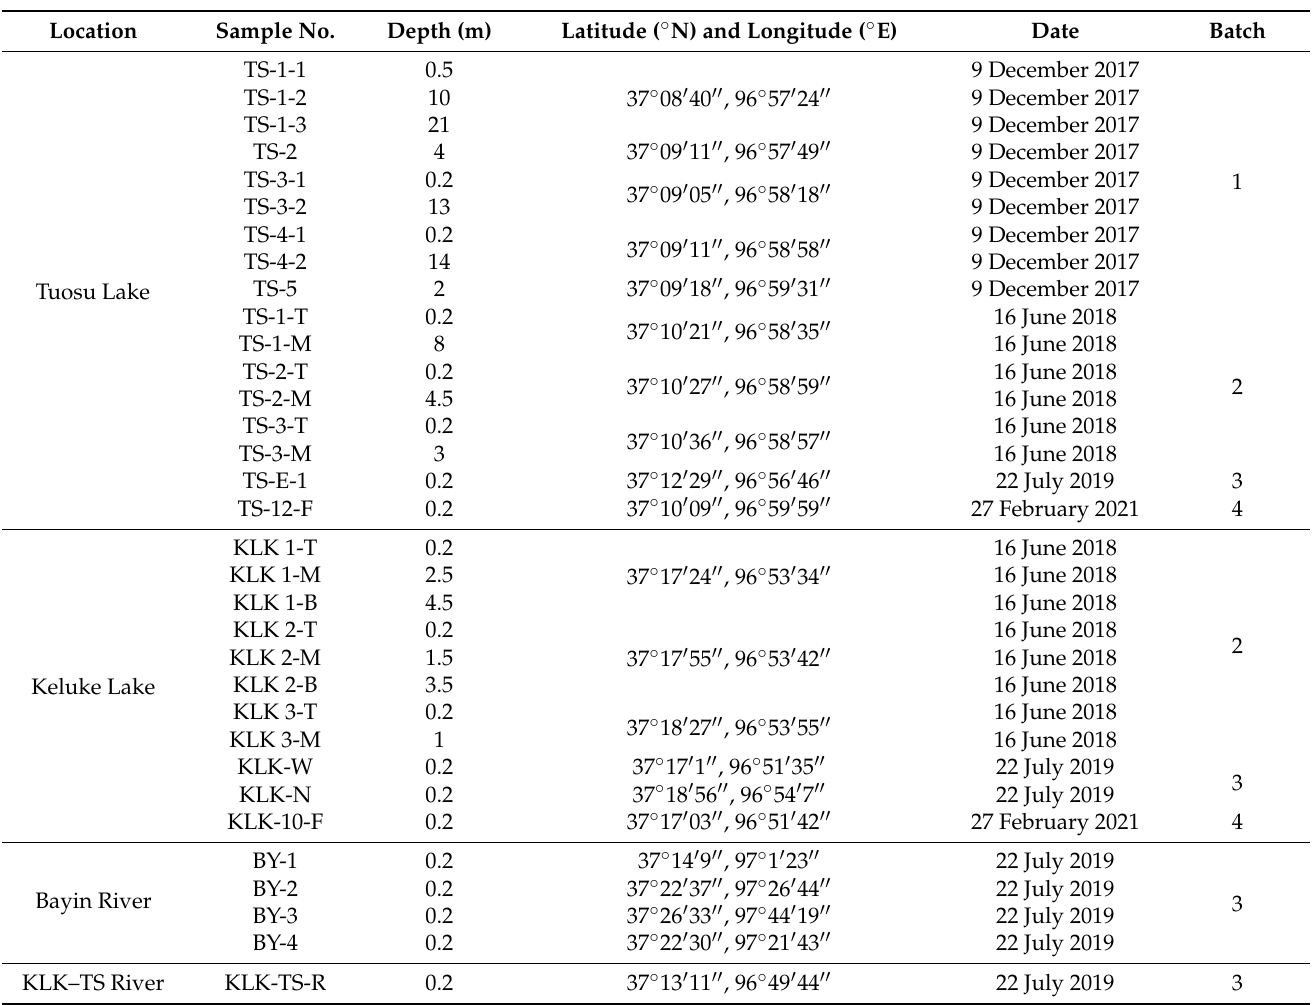
Table 1. Sample information for water